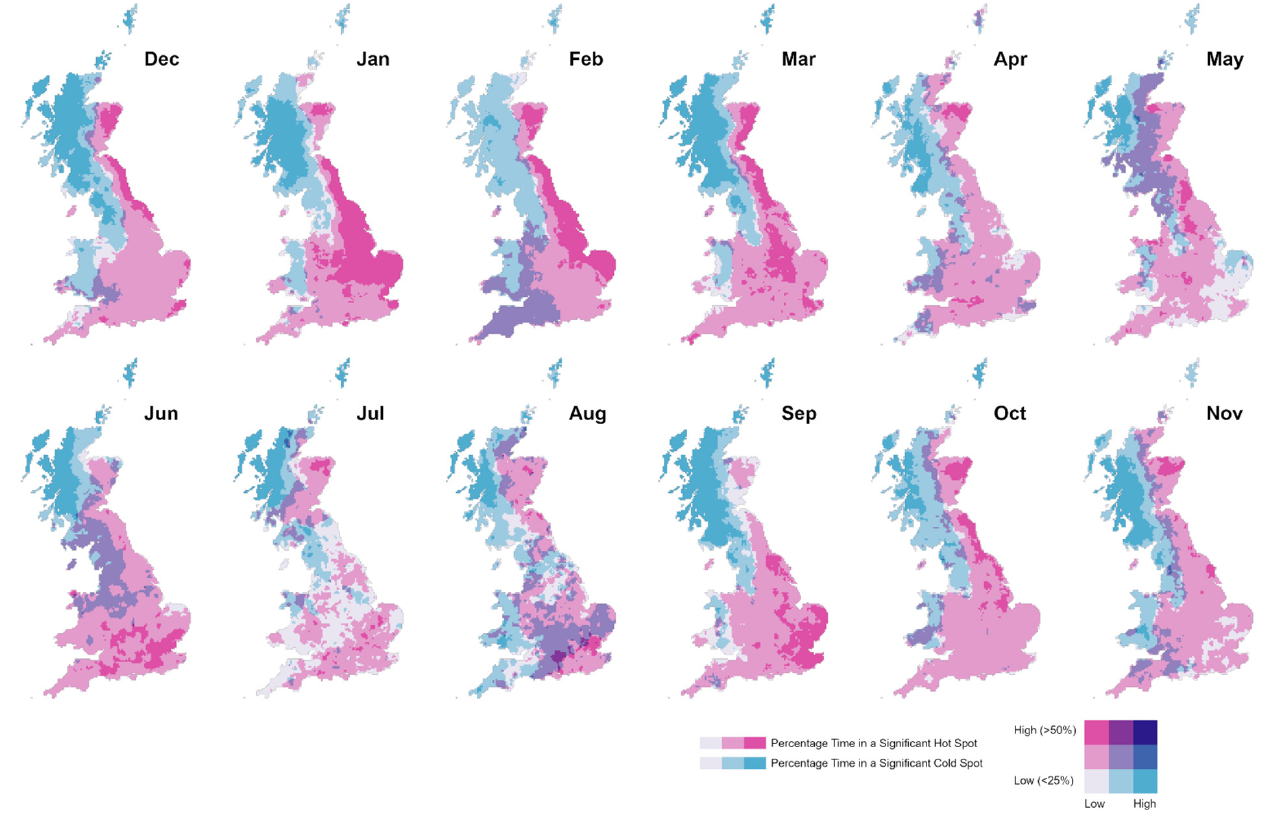
Figure 5. As per Figure 4 but under NAO − conditions.